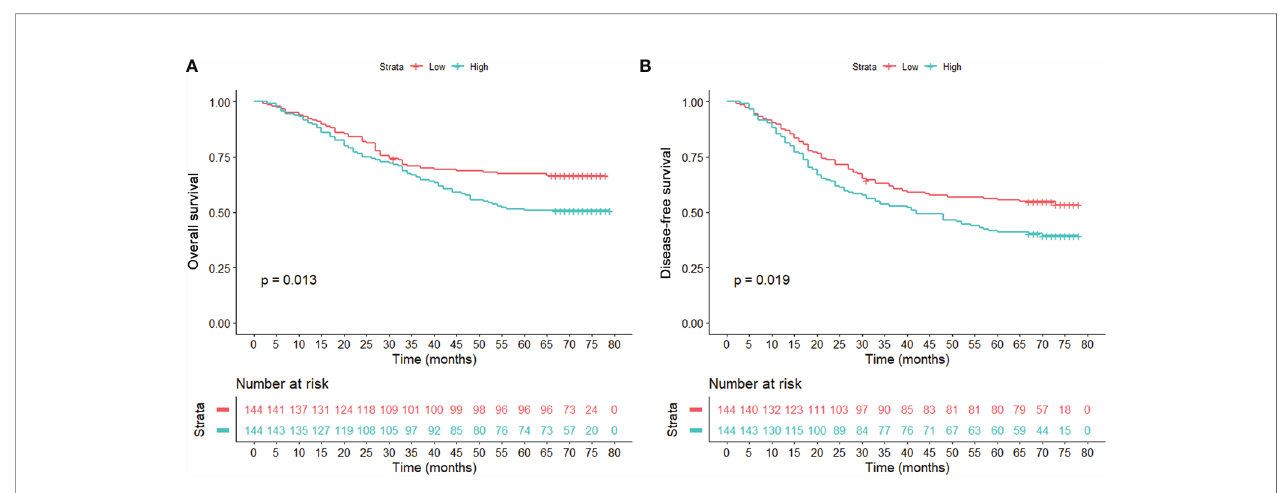
FIGURE 4 | Comparison of overall survival (A) and disease-free survival (B) between patients with high and low serum levels in the matched